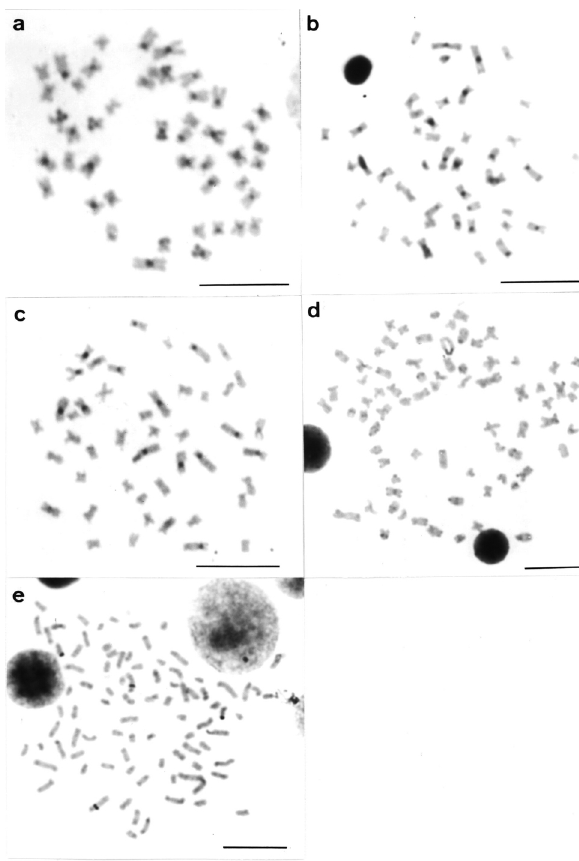
Figure 3 - Somatic metaphases treated with C-banding technique. a) Aspidoras taurus; b) A. cf . fuscoguttatus ; c) A. poecilus ; d) Corydoras sodalis; and e) C. britskii . Bars = 10 µ